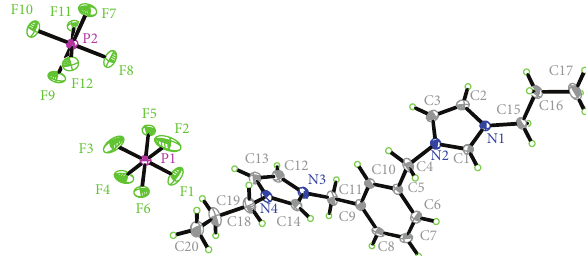
Figure 1: (a) The ORTEP picture of Ag-NHC complex 6 with displacement ellipsoids drawn at 50% probability. (b) The change in N–C–N bond angle before and after complexation with silver ion.